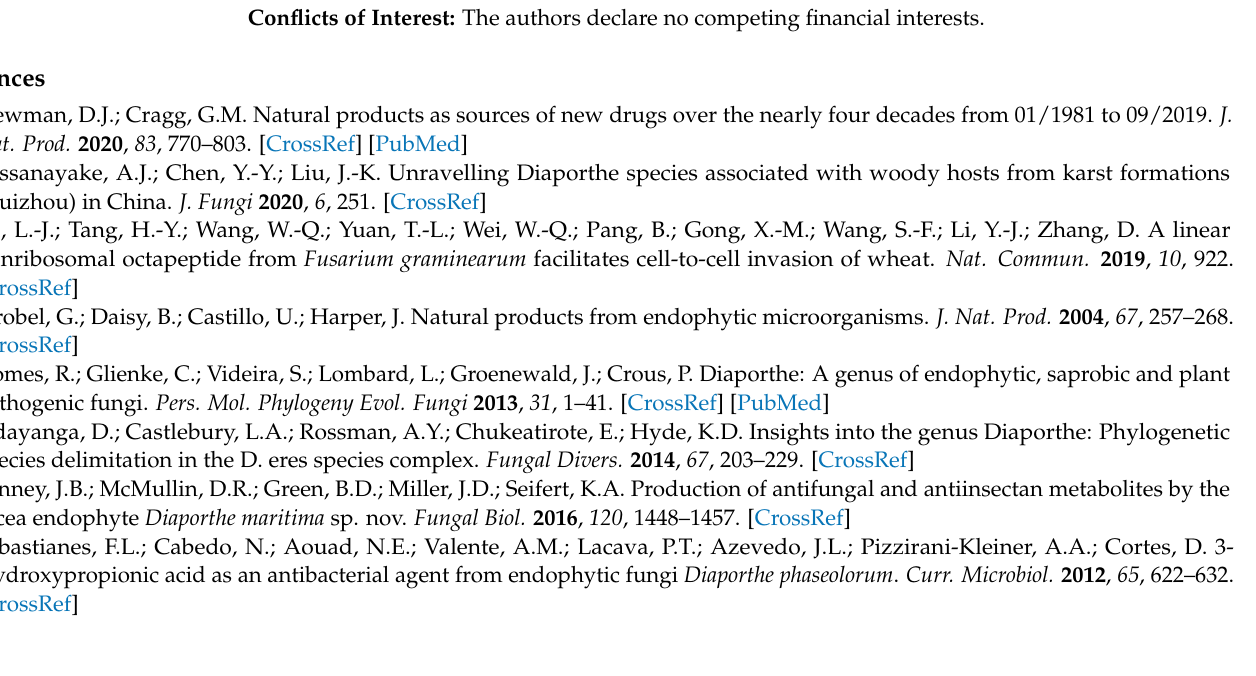
Table S2: X-ray crystallographic data for 2 ; Table S3: The inhibition rates of 1 ; against normal cells LO2 and HaCaT; Figure S1: Phylogenetic analysis of Diaporthe unshiuensis YSP3; Figure S2: The 1 H-NMR spectrum of 1 in acetone- d 6 ; Figure S3: The 13 C-NMR spectrum of 1 in acetone- d 6 ; Figure S4: The HSQC spectrum of 1 in acetone- d 6 ; Figure S5: The HMBC spectrum of 1 in acetone- d 6 ; Figure S6: The 1 H- 1 H COSY spectrum of 1 in acetone- d 6 ; Figure S7: The NOESY spectrum of 1 in acetone- d 6 ; Figure S8: The DEPT spectrum of 1 in acetone- d 6 ; Figure S9: The 1 H-NMR spectrum of 2 in CDC l3 ; Figure S10: The 13 C-NMR spectrum of 2 in CDC l3 ; Figure S11: The HSQC spectrum of 2 in CDC l3 ; Figure S12: The HMBC spectrum of 2 in CDC l3 ; Figure S13: The 1 H- 1 H COSY spectrum of 2 in CDC l3 ; Figure S14: The NOESY spectrum of 2 in CDC l3 ; Figure S15: The 1 H-NMR spectrum of 3 in acetone- d 6 ; Figure S16: The 13 C-NMR spectrum of 3 in acetone- d 6 ; Figure S17: The HSQC spectrum of 3 in acetone- d 6 ; Figure S18: The HMBC spectrum of 3 in acetone- d 6 ; Figure S19: The 1 H- 1 H COSY spectrum of 3 in acetone- d 6 ; Figure S20: The NOESY spectrum of 3 in acetone- d 6 ; Figure S21: The DEPT spectrum of 3 in acetone- d 6 ; Figure S22: The 1 H-NMR spectrum of 4 in acetone- d 6 ; Figure S23: The 13 C-NMR spectrum of 4 in acetone- d 6 ; Figure S24: The HSQC spectrum of 4 in acetone- d 6 ; Figure S25: The HMBC spectrum of 4 in acetone- d 6 ; Figure S26: The 1 H- 1 H COSY spectrum of 4 in acetone- d 6 ; Figure S27: The NOESY spectrum of 4 in acetone- d 6 ; Figure S28:The DEPT spectrum of 4 in acetone- d 6 ; Figure S29: 1 H NMR of S -MTPA spectrum of 4 in acetone- d 6 ; Figure S30: 1 H NMR of R -MTPA spectrum of 4 in acetone- d 6